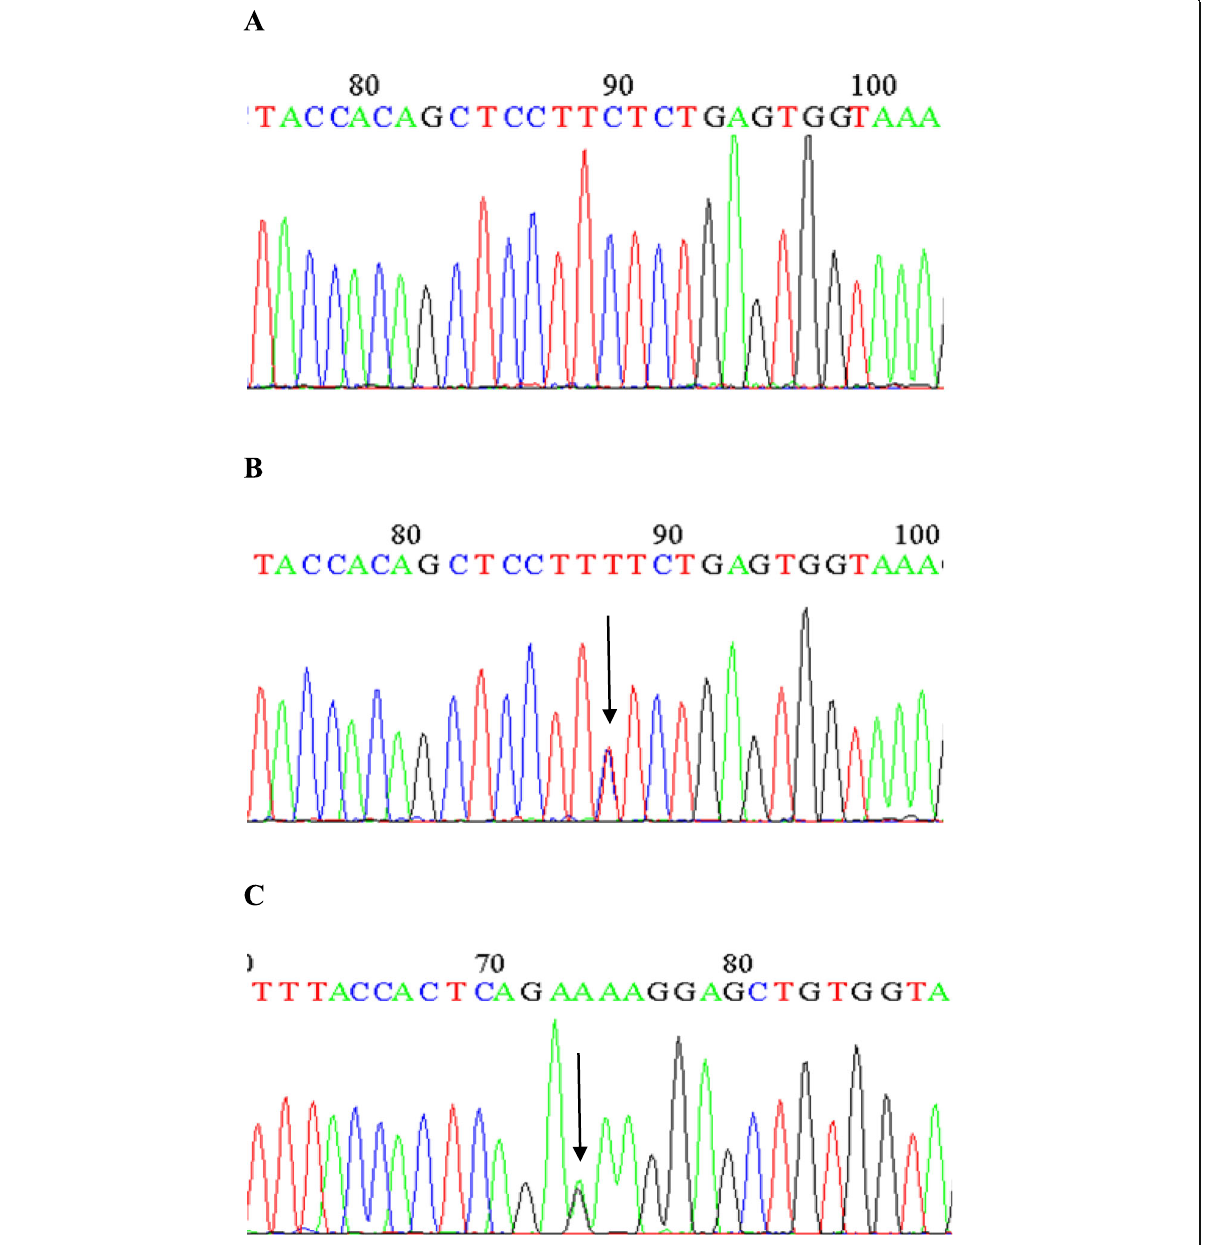
Fig. 1 Sequence analysis of CTNNB1 exon 3 in colorectal cancer tissue and corresponding normal tissue of the same patient. Heterozygous mutation at codon 33 (TCT to TTT) in tumor. Chromatogram of CTNNB1 exon 3, ( a ): DNA from normal tissue with wild type codon TCT (S33) sequenced with forward primer and ( b ), ( c ): DNA from tumor tissue with heterozygous mutation S33F (TTT > TCT) sequenced with forward primer and with reverse